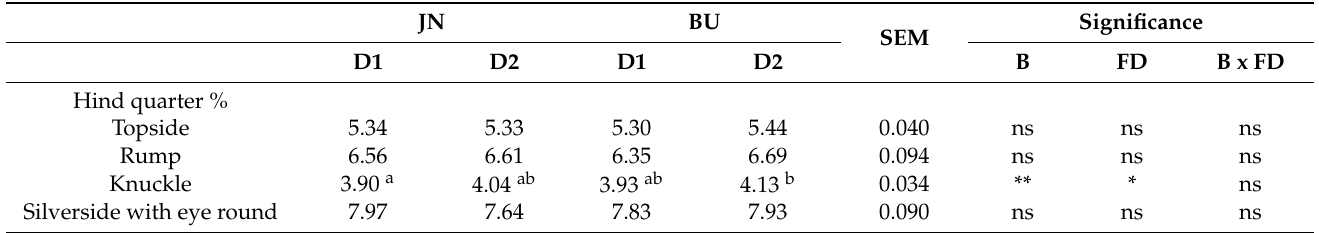
Table 3. Effect of breed and finishing diet on main commercial meat cuts of leg from Jaca Navarra (JN) and Burguete (BU) foals.